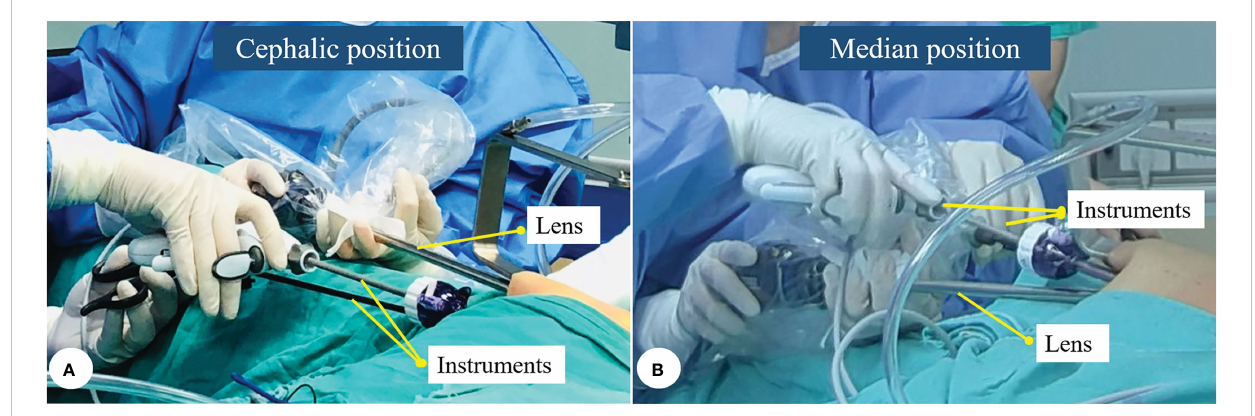
FIGURE 4 The endoscopic lens was placed in the cephalic (A) or median position (B) .